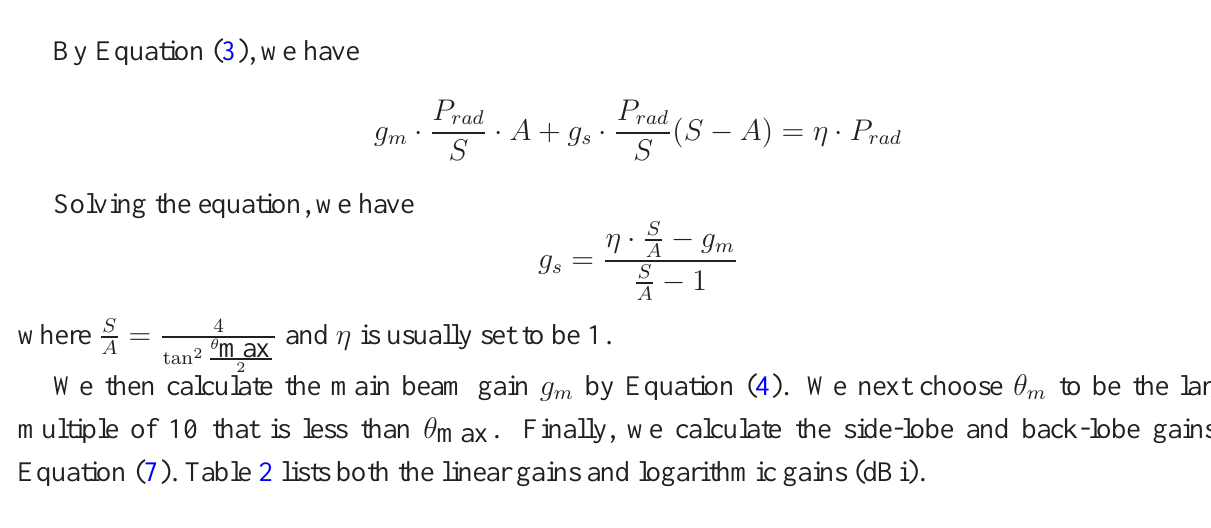
Table 2. Antenna gains (linear and